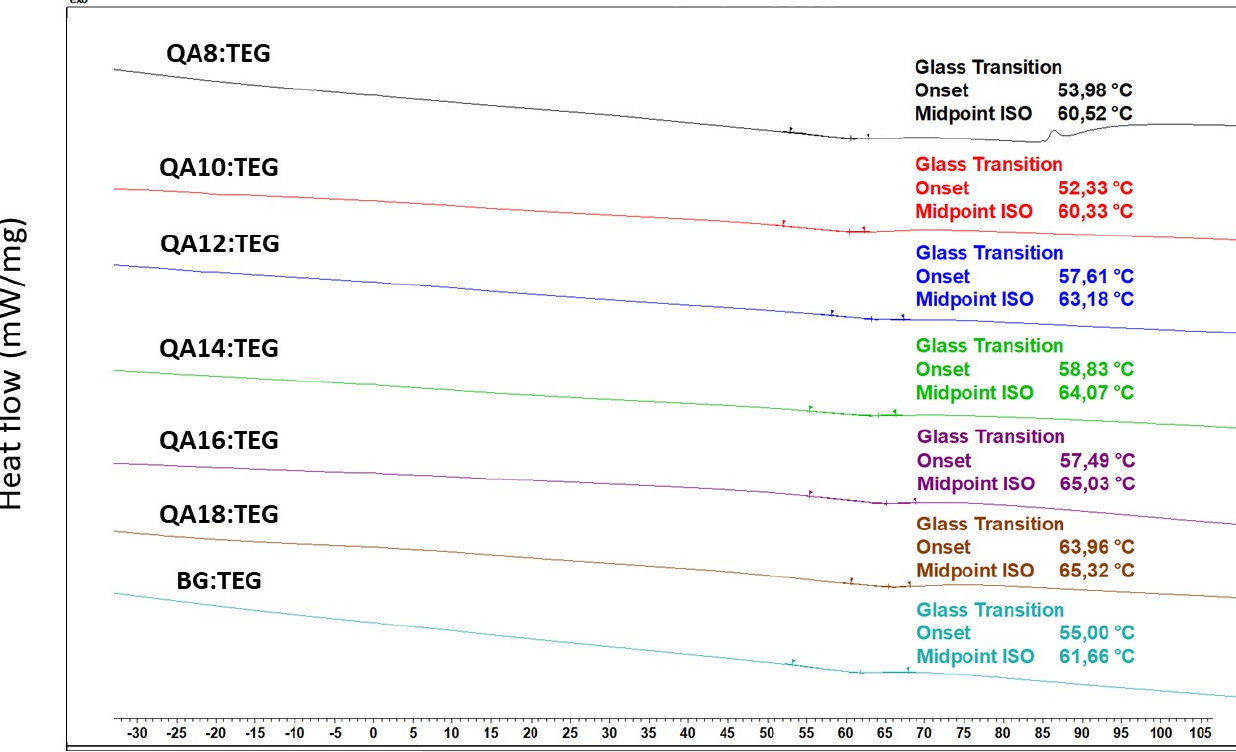
Figure 4. DSC thermograms of copolymers showing their glass transition temperatures.